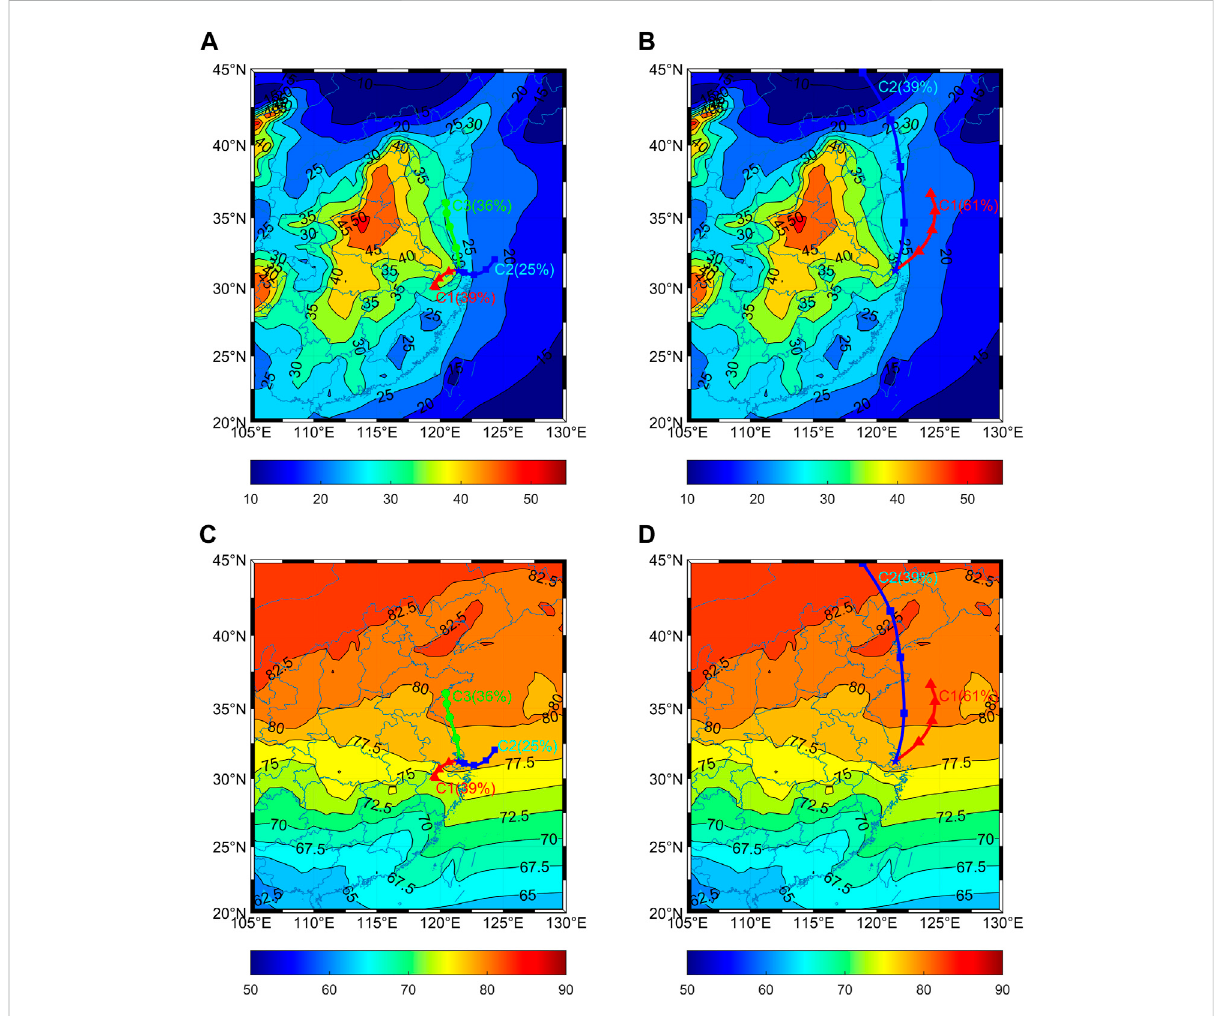
FIGURE 6 Transport pathways of air masses in 5 clusters with (A,B) PM 2.5 mean concentration and (C,D) O 3 mean concentration (ppb). The background PM 2.5 concentration is the annual average from 2014 to 2020, sourced from MERRA-2. The background ozone concentration is the annual average from 2014 to 2020, sourced from